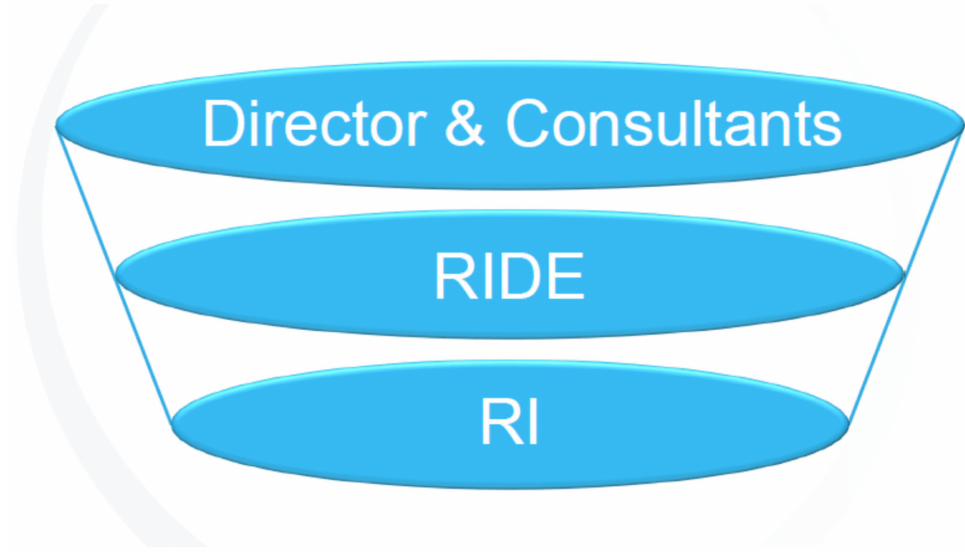
Figure 1. Containment of diversity